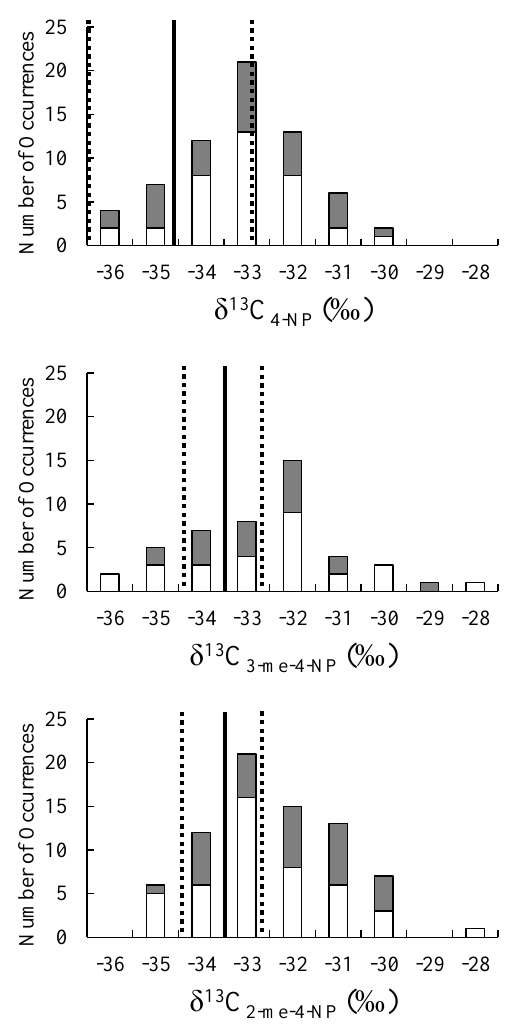
Figure 4. Frequency distribution of ambient stable carbon iso- tope ratios of 4-nitrophenol, 3-methyl-4-nitrophenol and 2-methyl- 4-nitrophenol for samples collected in PM alone (white) and in the gas phase and PM together (gray). The solid vertical line in each of the graphs represents the delta value of the nitrophenol formed from the reaction of unprocessed precursor emissions, which is cal- culated from the carbon isotope ratio of precursor emissions and the KIE for reaction of the precursor with the OH radical and the dashed vertical lines represent the uncertainty (Table